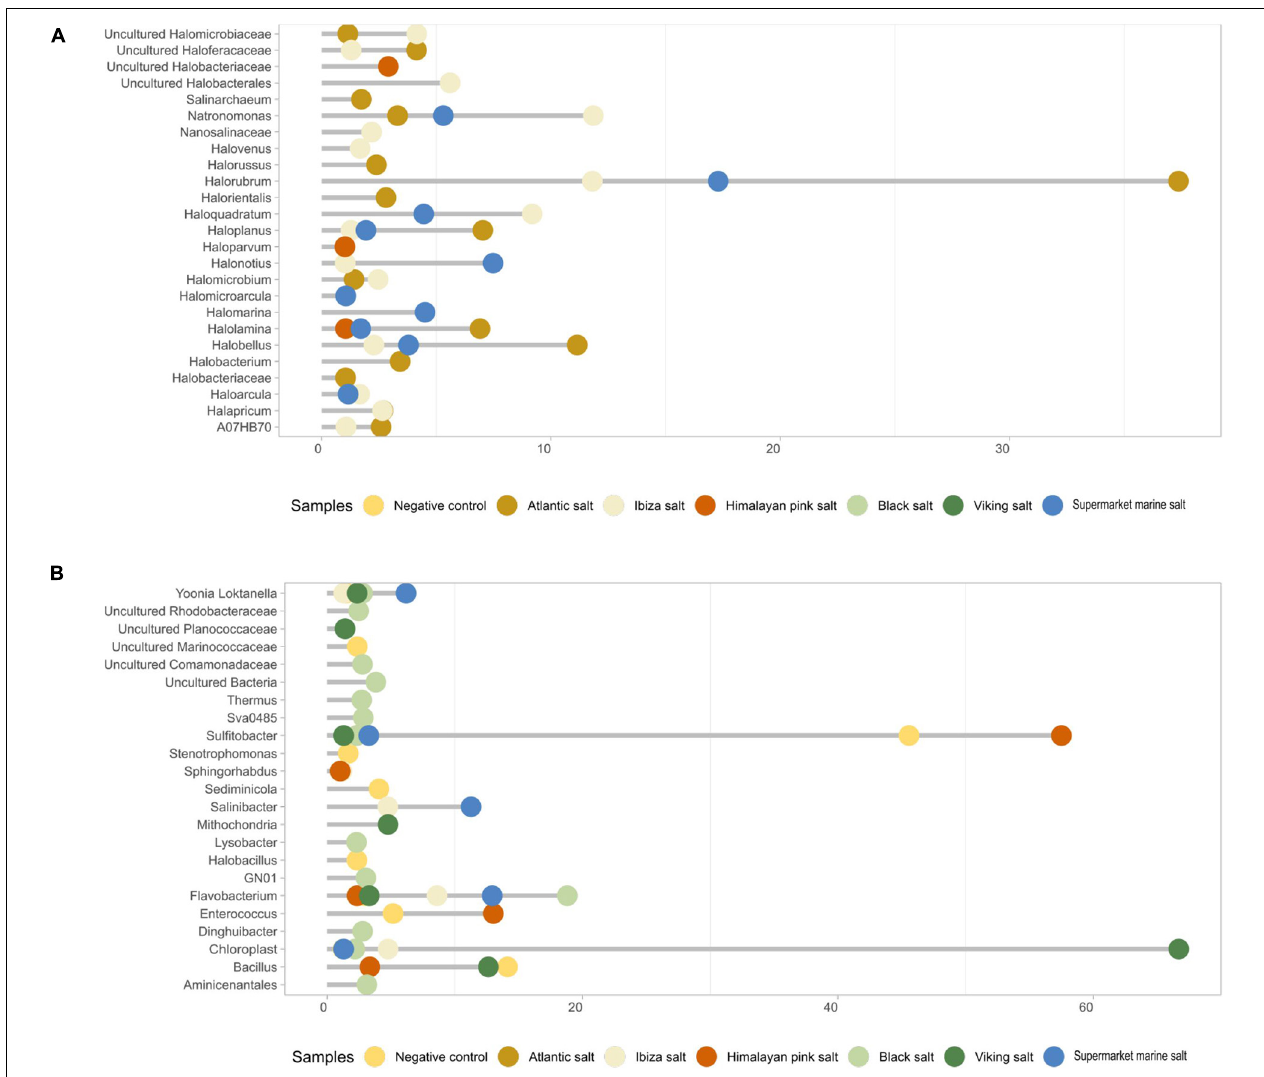
FIGURE 4 | Main archaeal composition (A) and bacterial composition (B) of each table salt sample based on the 16S rRNA gene metagenomic analyses with archaea-specific primers. Only values higher than 1% are shown to explain the biodiversity of the